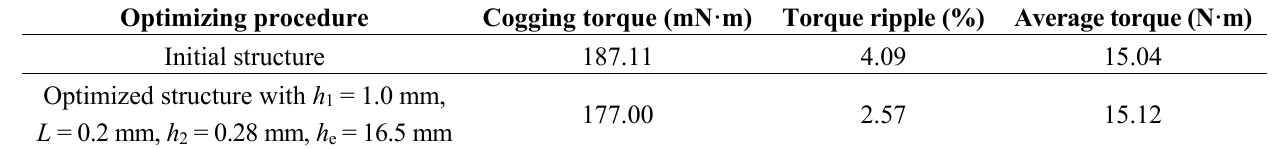
Table 6. Torque characteristics before and after optimizing the eccentric and notched teeth combination.